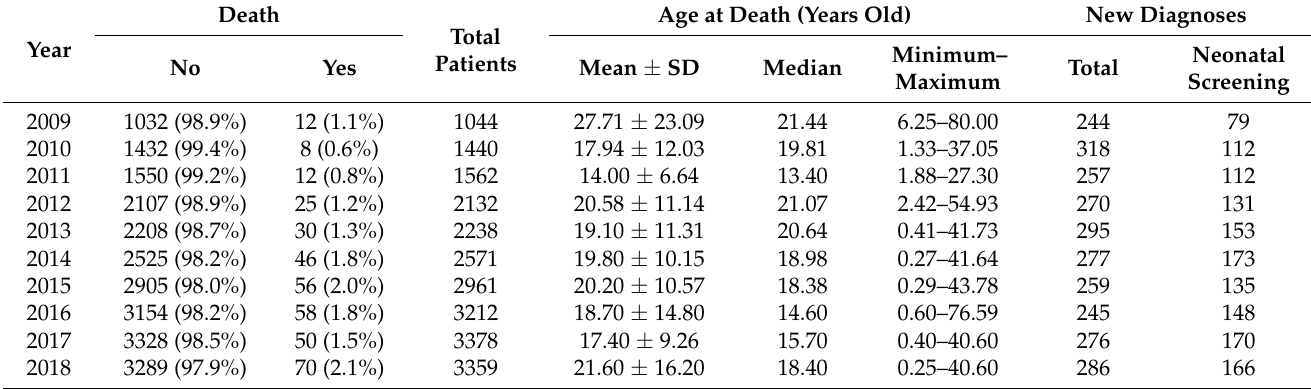
New Diagnoses Neonatal